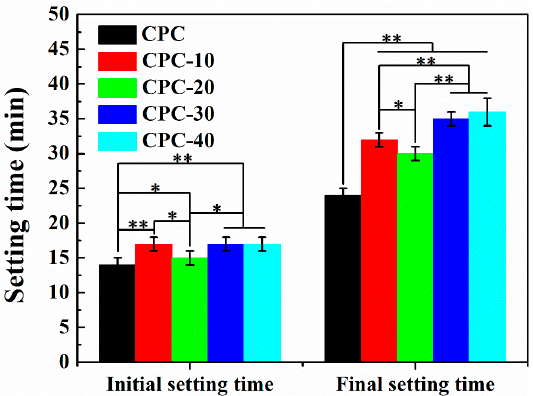
Figure 2. Setting time of control CPC and PLGA-PEG-PLGA/CPCs (n = 6). * indicates statistically significant differences between groups (** p < 0.001, * p < 0.05).